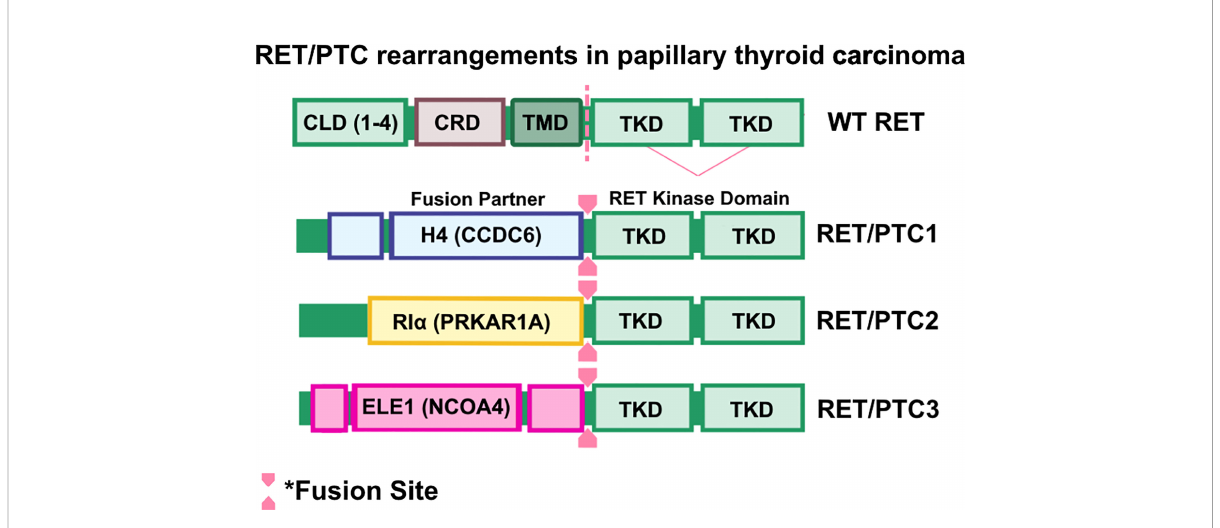
FIGURE 3 RET/PTC rearrangements in papillary thyroid carcinomas. Wild-type RET and RET rearrangements in papillary thyroid carcinoma (PTC). Coiled- Coil domain containing 6 (CCDC6)-RET, Protein Kinase CAMP-Dependent Type I Regulatory Subunit Alpha (PRKAR1A)-RET, and nuclear receptor coactivator 4 (NCOA4)-RET are frequently found in PTC cases. Oncogenic RET fusions lack the transmembrane domain (TMD) and result in chimeric, cytosolic proteins that are constitutively